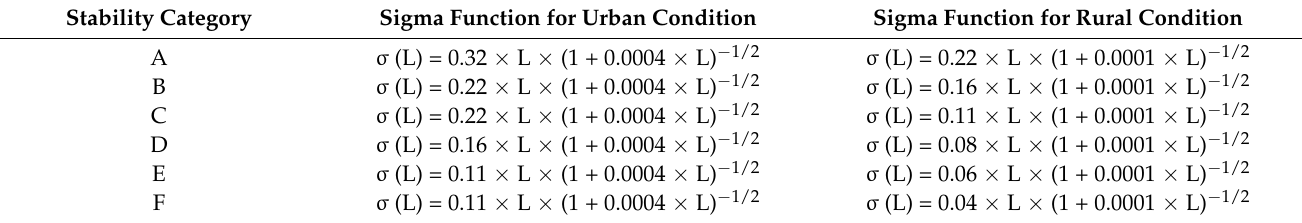
Table 2. The applied Briggs sigma function σ (L) for the horizontal Gaussian model, where L is the travel length. Stability Category Sigma Function for Urban Condition Sigma Function for Rural